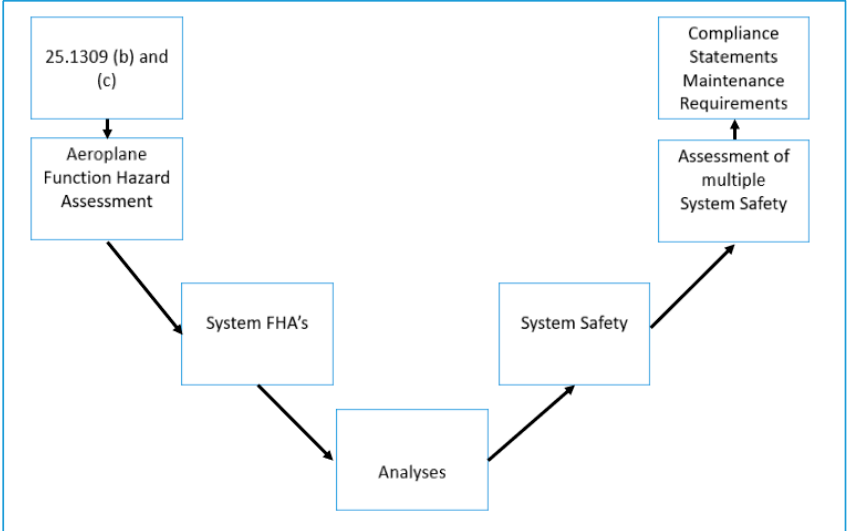
Figure 6. CS-25 safety process logics, (adapted from [24]).